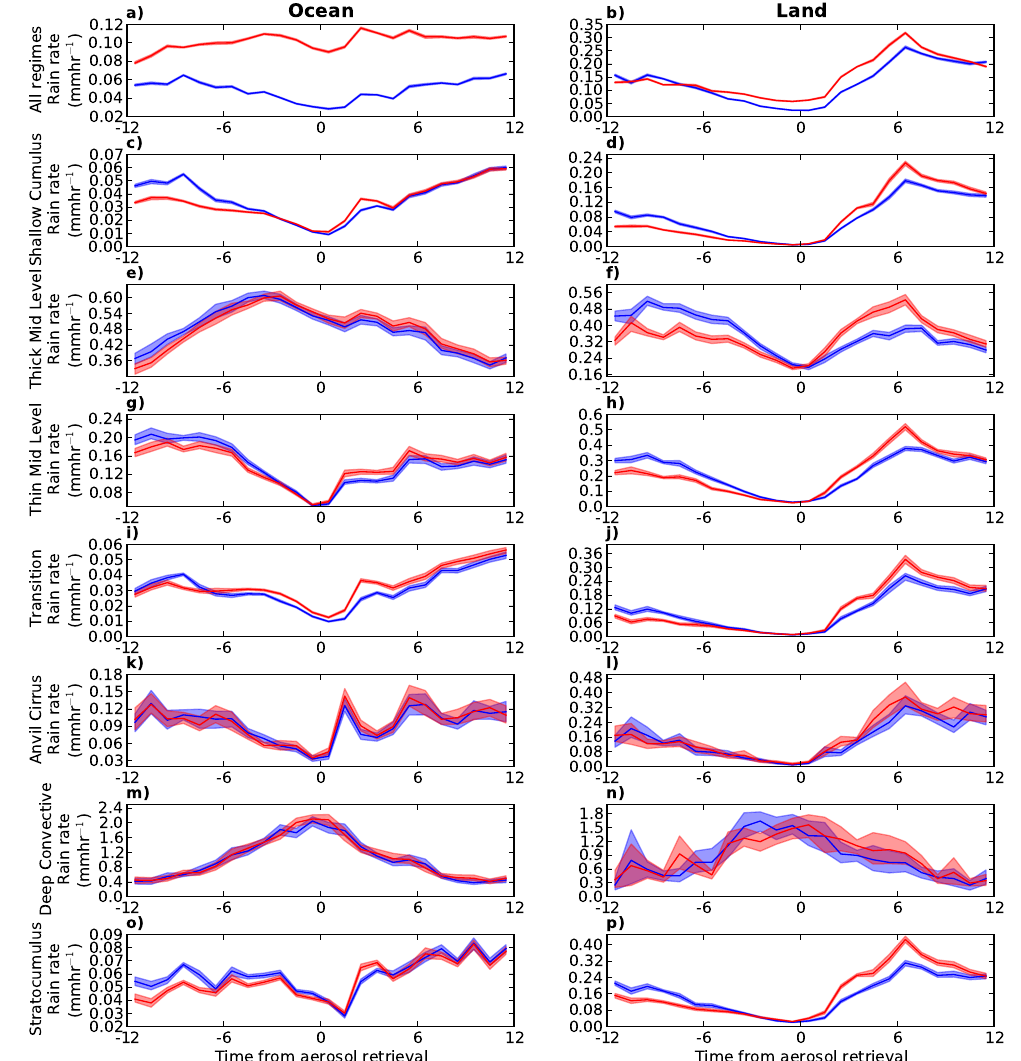
Figure 3. As Fig. 2, but using Terra MODIS for the cloud and aerosol retrievals, giving a T + 0 of 10:30LST.